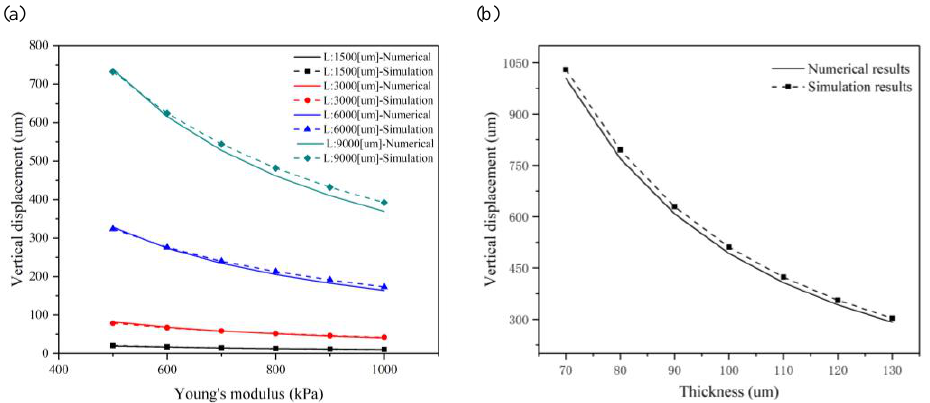
Figure 3. The numerical and simulation results of the maximum displacements at the free end of a plain microcantilever with different a Young’s modulus and substrate thickness: ( a ) the effect of Young’s modulus on the maximum displacement of the plain microcantilever with different sizes (the microcantilever lengths are 1500, 3000, 6000, and 9000 μm, respectively; the aspect ratio is 3:1; and thickness is 100 μm) when the contractile force is 2 nN/μm 2 ; ( b ) the effect of substrate thickness on a maximum displacement when the microcantilever length is 9000 μm and the contractile force is 2 nN/μm 2 .